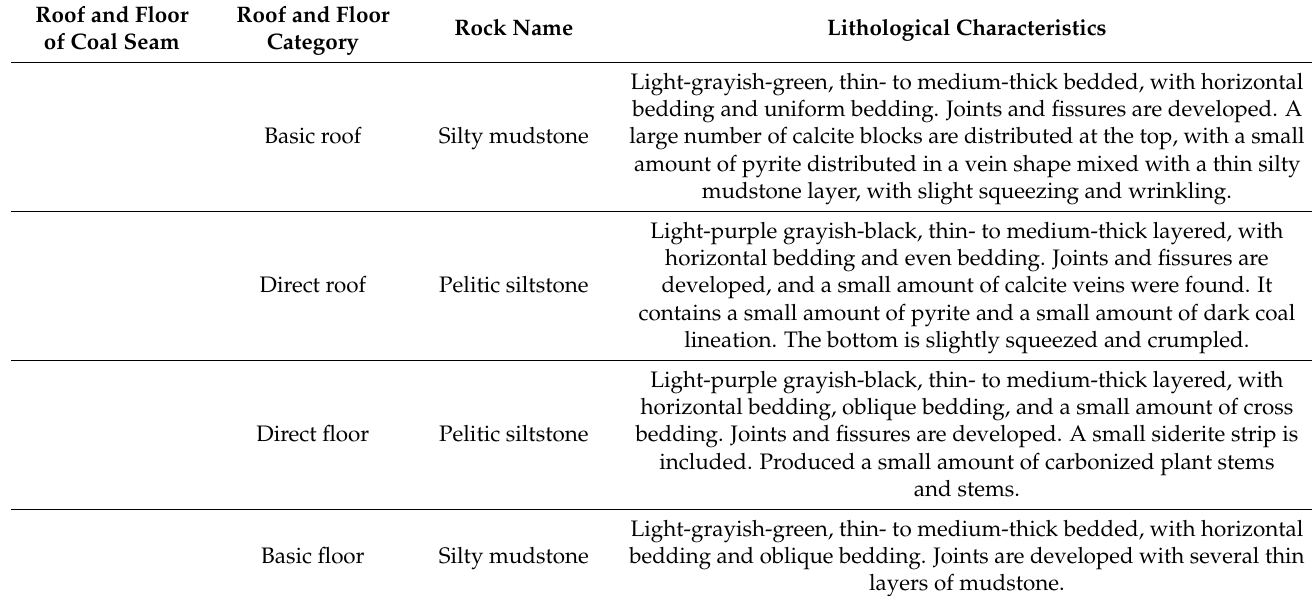
Table 1. Rock properties of the roof and bottom